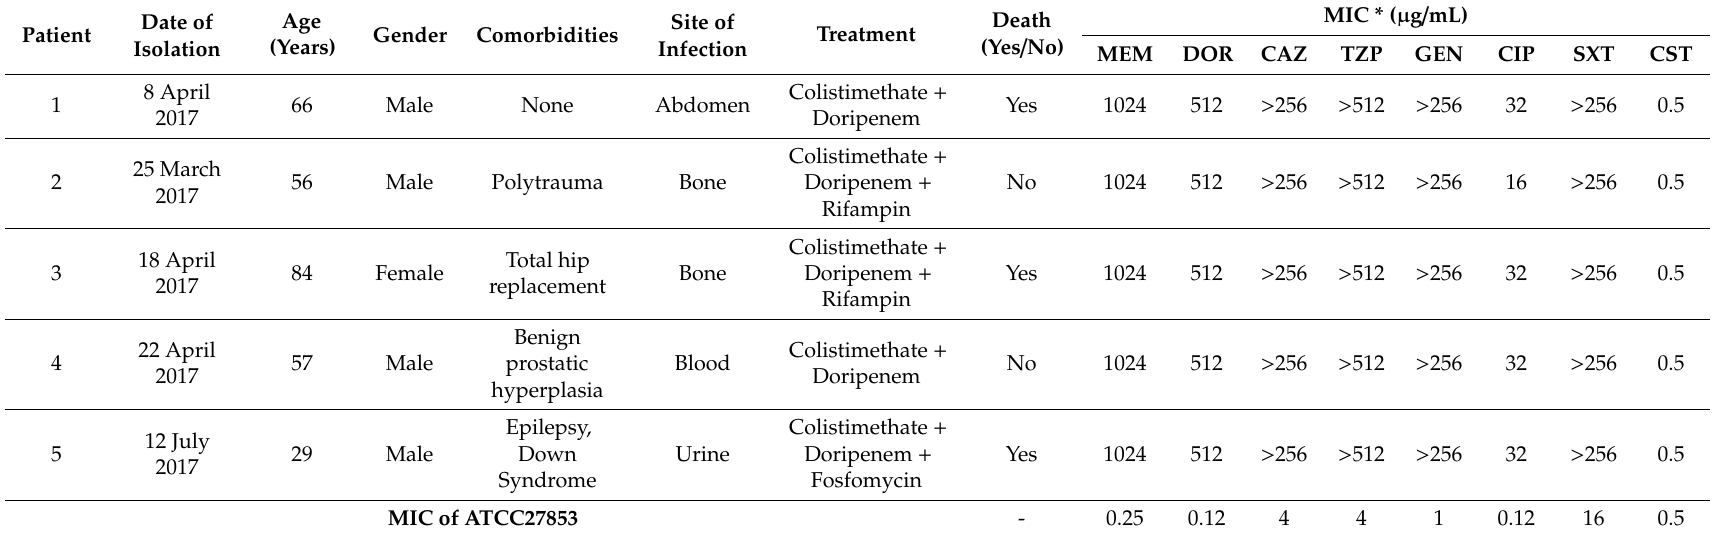
Table 1. Relevant clinical characteristics of